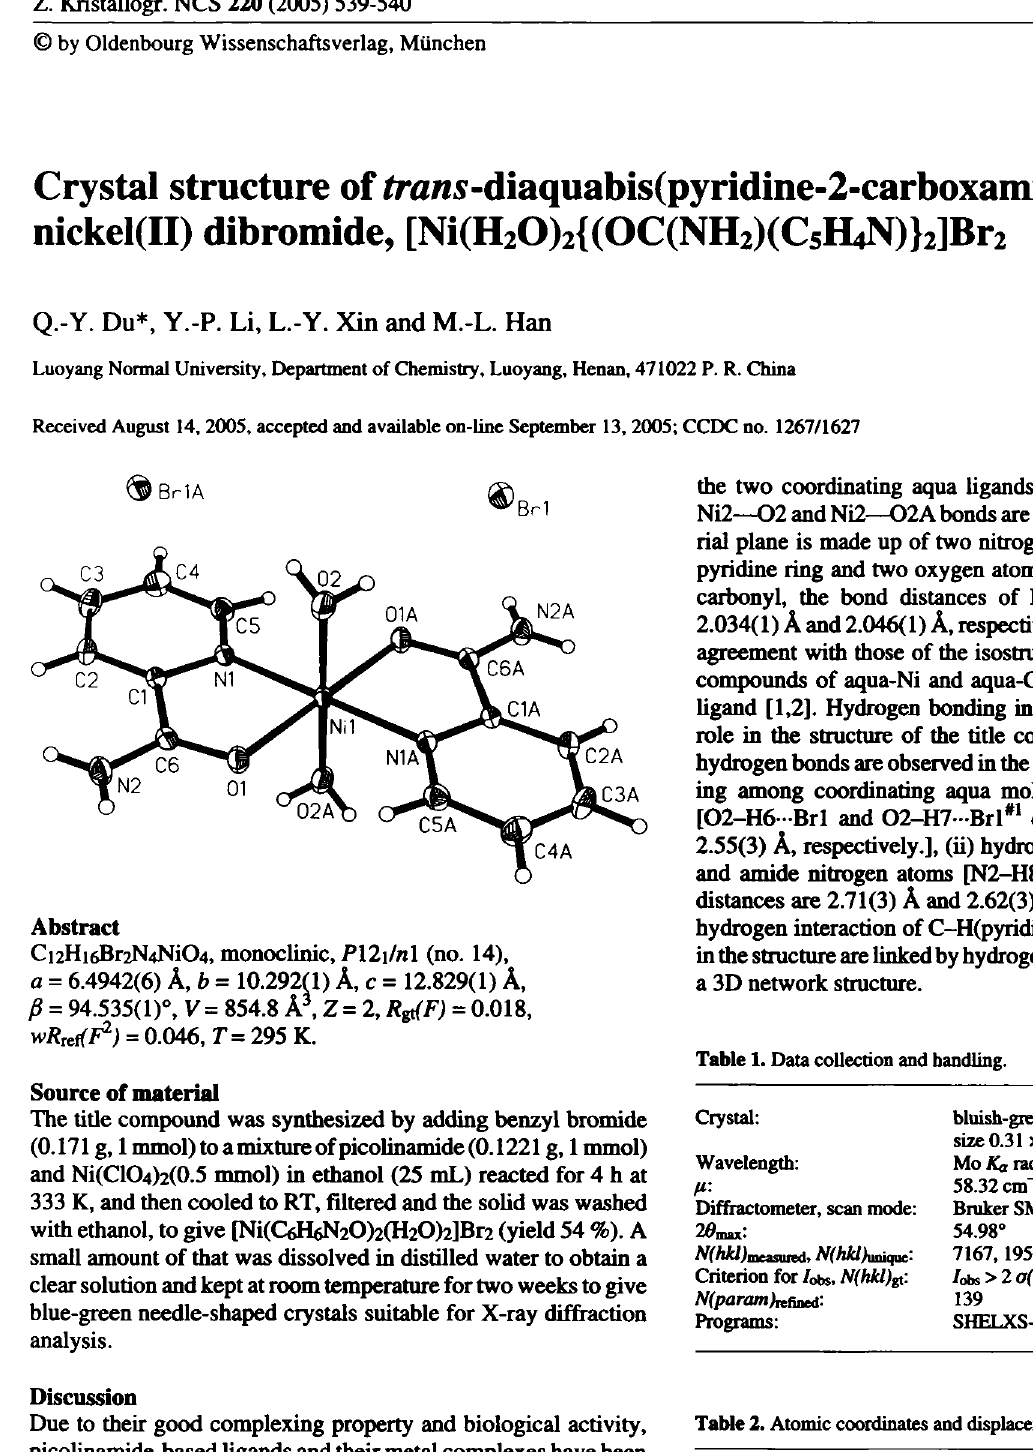
Table 2. Atomic coordinates and displacement parameters (in Ä 2